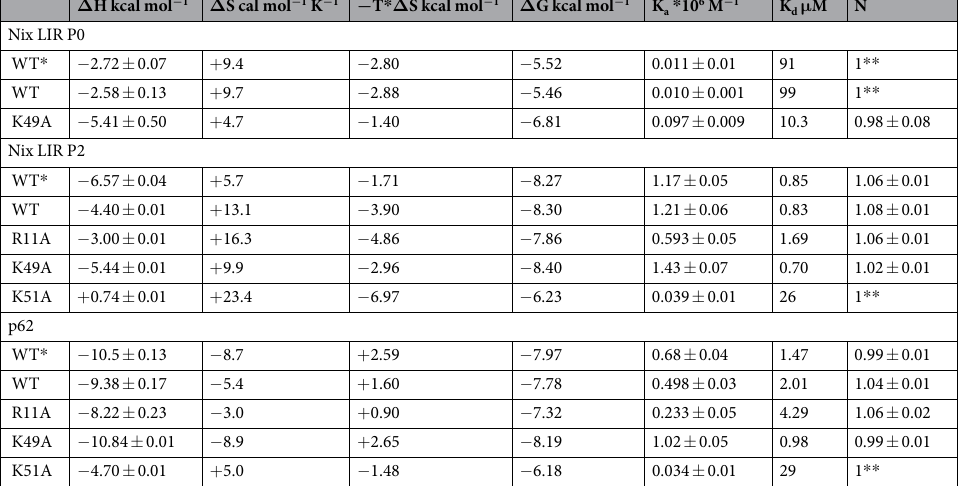
Table 1. Thermodynamic parameters of interaction between LC3B (wild type and mutants), and Nix and p62 LIRs. * Previous set of conditions reported by Novak et al . 16 − 50 mM NaPi, 150 mM NaCl, pH = 7.5. ** N was fixed to 1.00 upon fitting.